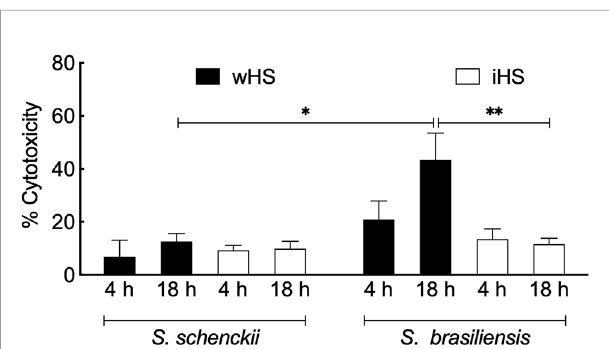
FIGURE 3 | Sporothrix mediated cytotoxicity of human monocyte-derived macrophages (hMDMs) . Sporothrix schenckii or Sporothrix brasiliensis yeasts were incubated with hMDMs at 37°C in a CO 2 incubator for 4 – 18 h in the medium containing whole (wHS) or inactivated (iHS) human serum. Following, lactate dehydrogenase (LDH) activity was measured using CytoTox ® Non- Radioactive Cytotoxicity Assay (Promega) kit. Results are the mean ± SEM values of two independent experiments in duplicate. Statistical analysis was performed by ANOVA with Turkey ’ s multiple comparison posttest (**p < 0.005 and *p < 0.05).